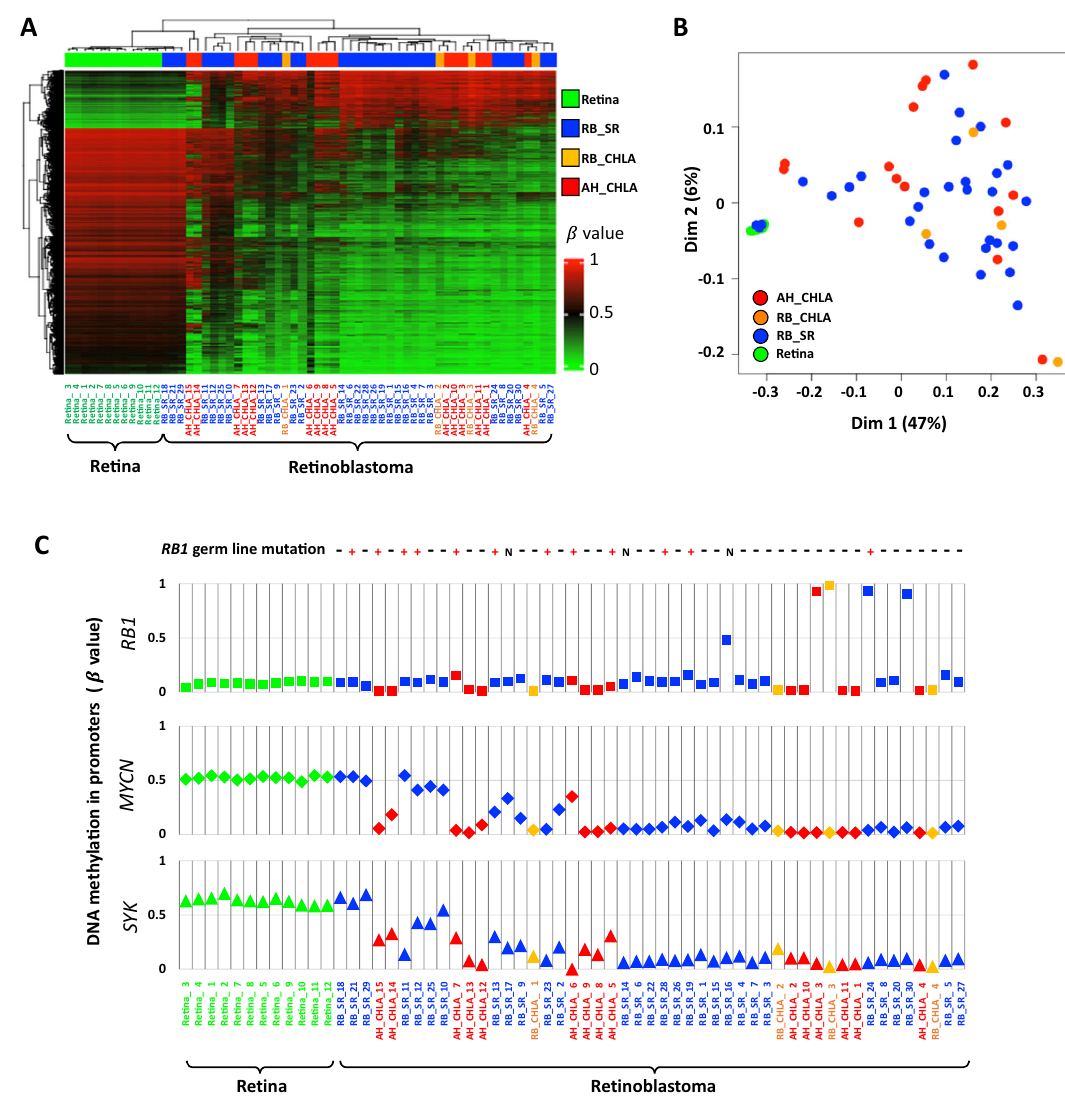
Fig. 3 | RB-speci fi c DNA methylation pro fi les are highly correlated in AH and primary tumors. A Unsupervised hierarchical clustering of differential DNA methylation between retina ( n =12) and RB samples including AH cfDNA ( n =15) and RB tumor samples ( n =34). The probes identi fi ed in Fig. 1A were used. B MDS plot showing AH cfDNA samples ( n =15) are clustered with primary RB tumor samples ( n =34) and separated from retina ( n =12). C Promoter DNA methylation RB1 , MYCN , and SYK genes in normal retina and RB samples. The RB1 germ line